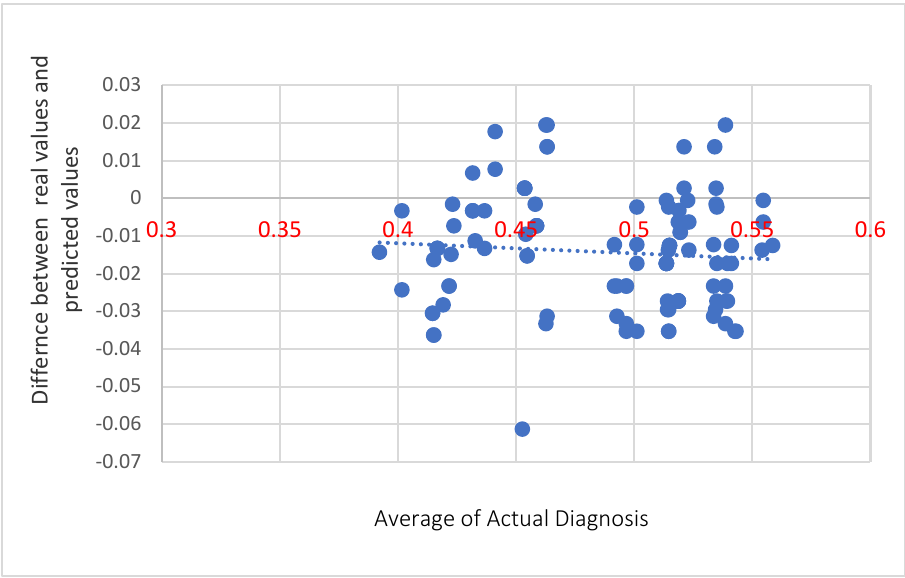
Figure 8. The Bland-Altman Plot that denotes the difference of the predicted values versus the average of actual diagnoses.